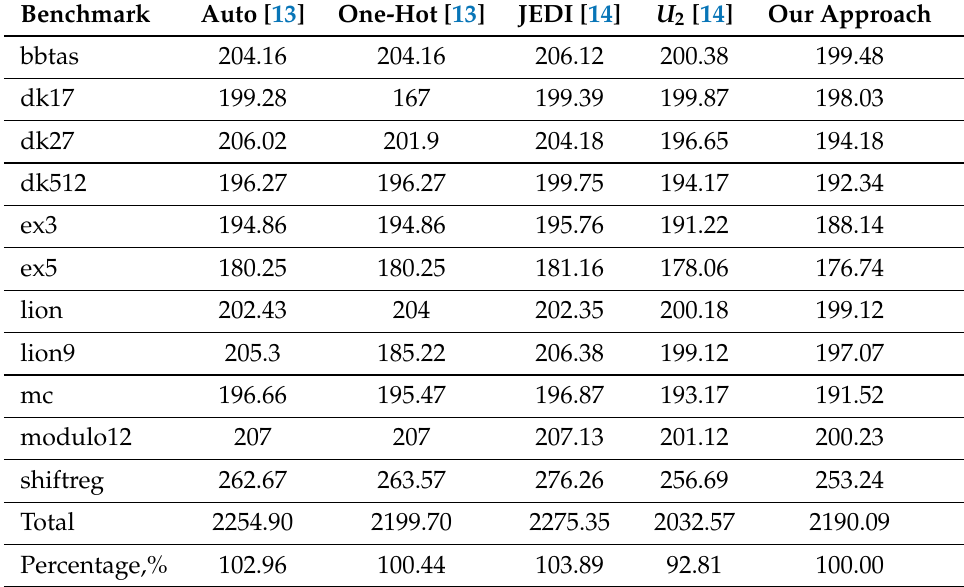
Table 13. Experimental results (the maximum operating frequency for G0).